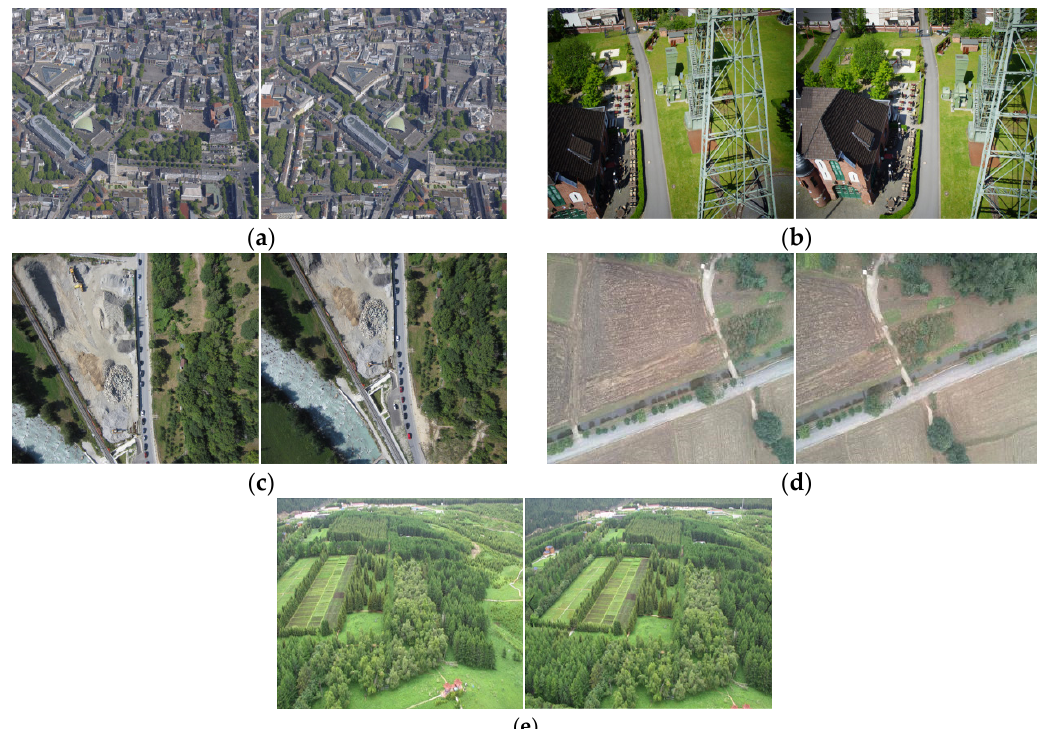
Figure 4. UAV visible-light images about different scenes: ( a ) Urban (2044 × 1533 pixels), ( b ) Buildings (3000 × 2000 pixels), ( c ) Roads (2000 × 1500 pixels), ( d ) Farmlands (2404 × 1728 pixels) and ( e ) Forests (1920 × 1080 pixels).